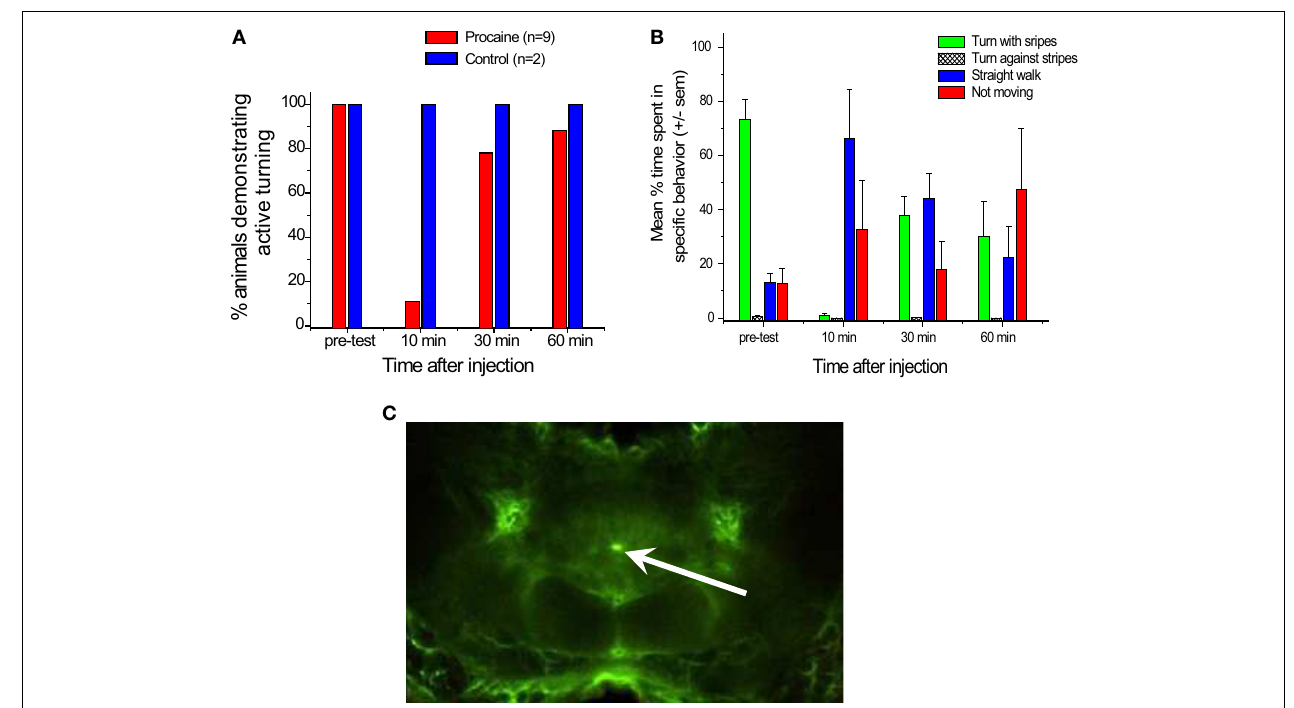
in which saline was injected into the central complex in the same way showed no changes after the injections. (B) . Responses of five cockroaches walking on an air-suspended ball to a moving stripe pattern in their visual field. Bars indicate average percentage of time spent turning with the stripes (green), turning against the stripes (hatched), walking straight ahead (blue) or not moving at all (red). Note that in the pre-test most trials showed the cockroach walking with the moving stripes, while 10min after injection of 20% procaine few trials followed the stripes and many more showed straight or no walking. At 30 and 60min, there was some recovery, but not completely back to normal. (C) . Confocal image of a brain injected with procaine mixed with fluorescein dextran for six pulses at 40ms and 30 ψ . The bright fluorescein dot at the center of the central complex between the fan-shaped body and ellipsoid body shows the injection